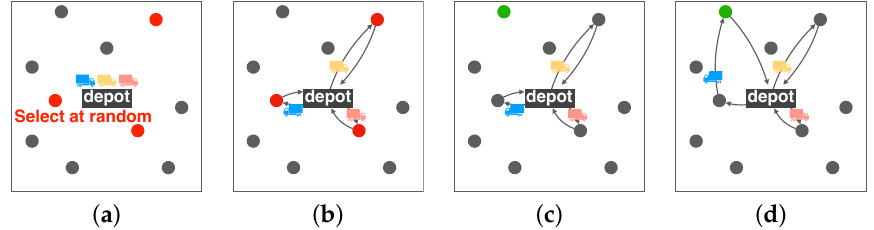
Figure 4. The farthest insertion method using three vehicles ( m = 3). Black rectangles indicate depots and circles represent ports. ( a ) Three red ports are randomly selected. ( b ) The selected red ports are visited by the vehicles. ( c ) The farthest port (green) from the depot is selected. ( d ) The farthest port is inserted into the tour of the blue